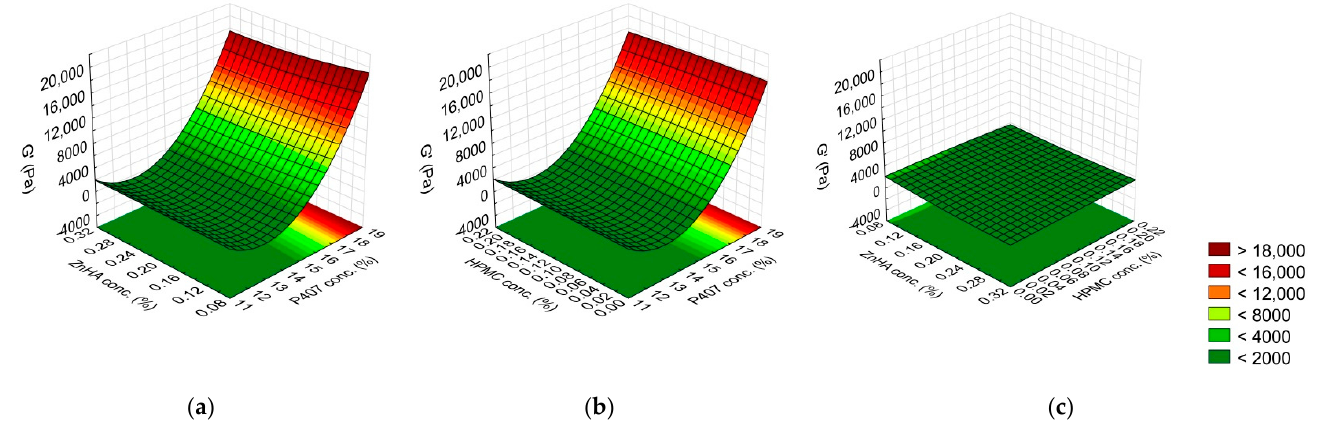
Figure 3. Effect of the composition on the G ′ modulus: ( a ) P407 and ZnHA concentrations, ( b ) P407 and HPMC concentrations, ( c ) ZnHA and HPMC; (the 3rd factor is at 0 level in each case).